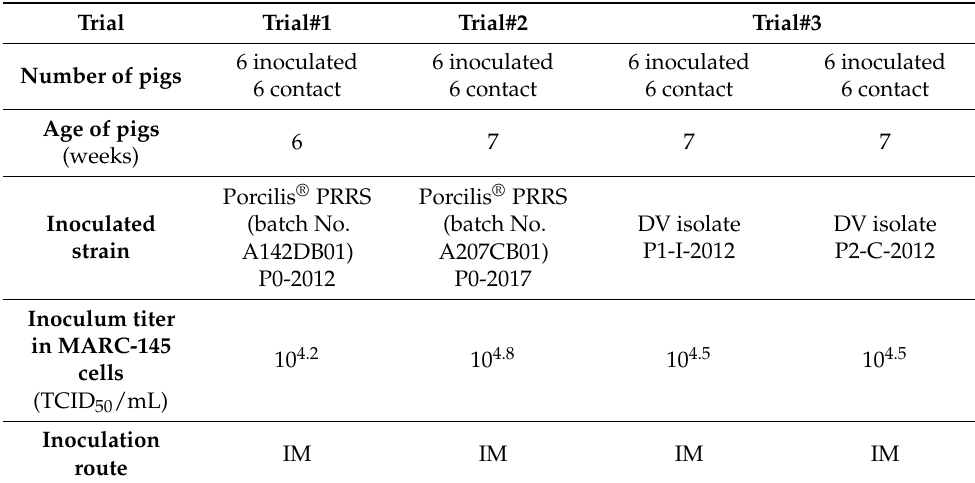
Table 1. Experiment parameters for Trial#1, Trial#2 and